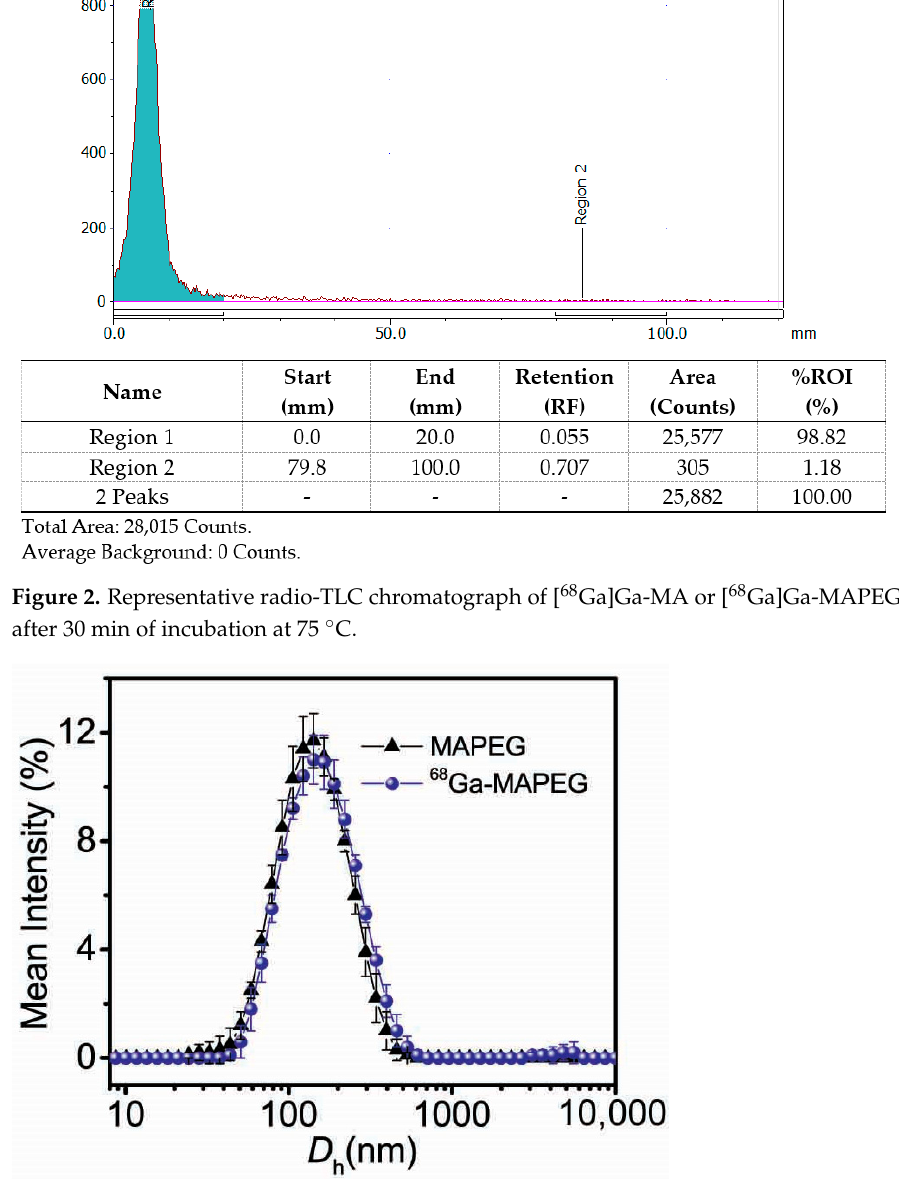
Figure 3. Size distribution of MIONs before (MAPEG) and after ( 68 Ga-MAPEG) radiolabeling with 68